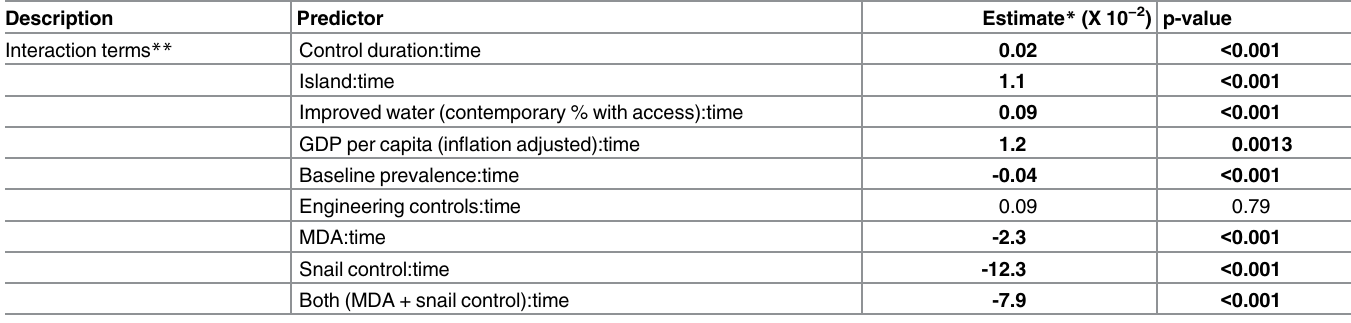
Table 3. Generalized linear mixed model (GLMM, see S2 and S3 Tables) comparing change in prevalence for control programs using: MDA with praziquantel, snail control primarily (snail control), both (MDA + snail control), or minimal control ( < 30% coverage, “ low coverage, ” not shown).